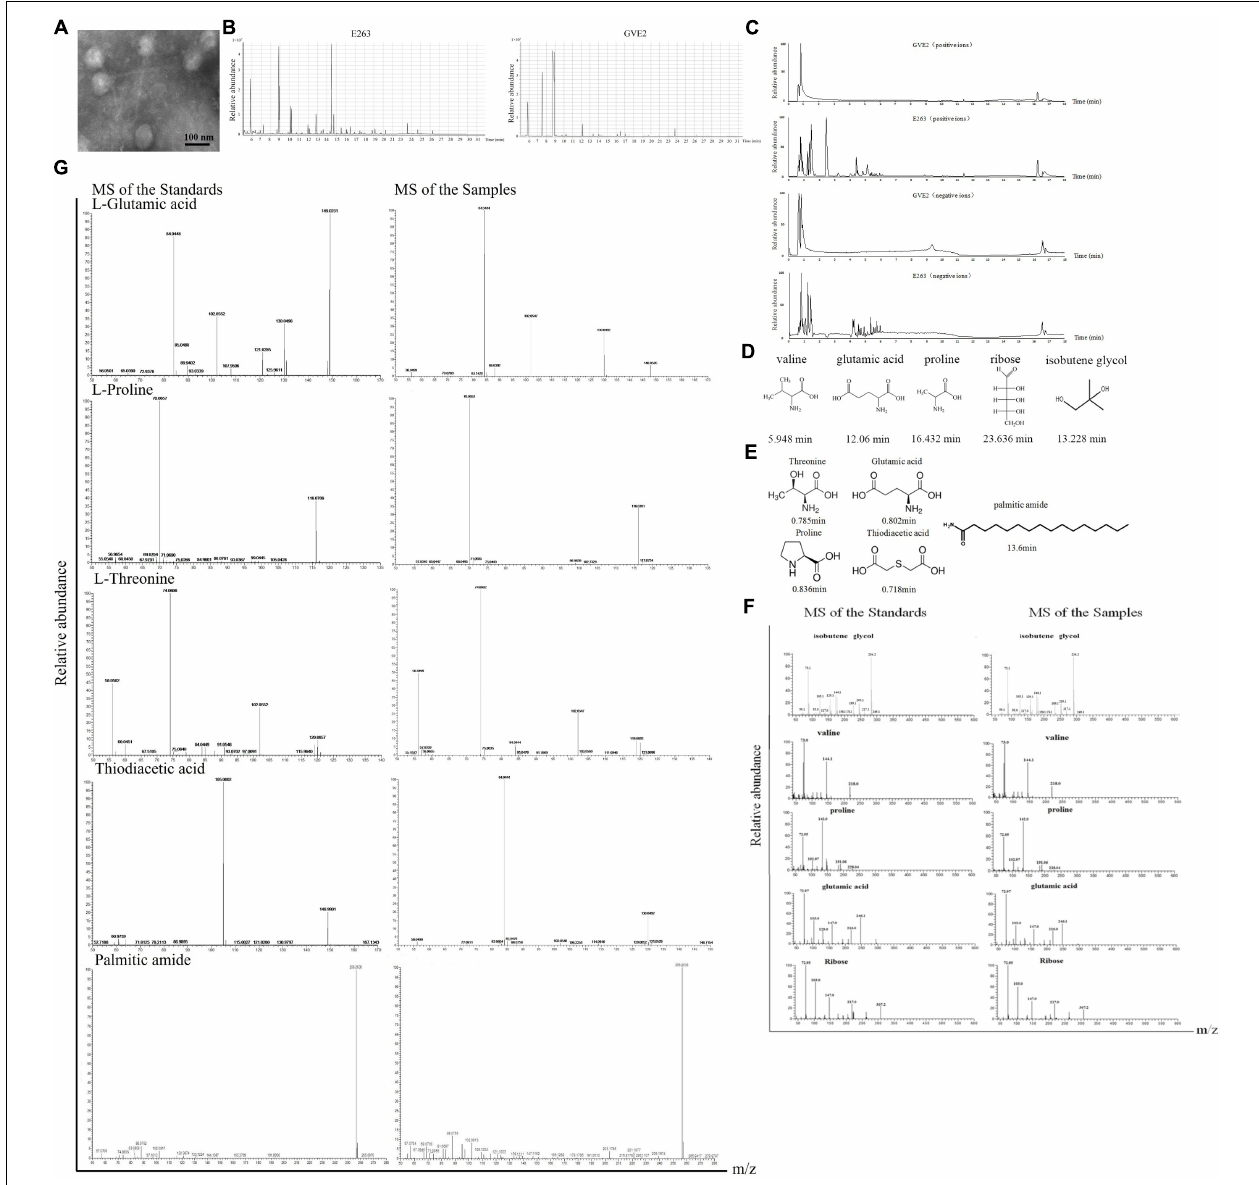
FIGURE 1 | Identification of metabolites packaged in virus particles. (A) Purification of virions. The purity of purified GVE2 virions was examined with transmission electron microscopy. Scale bar, 100 nm. (B) GC-MS analysis of the metabolites extracted from the purified virions and the virus-infected bacteria. Geobacillus sp. E263 was infected by its bacteriophage GVE2. At 1 h post-infection, the bacteria were subjected to compound extraction. The compounds extracted from the purified GVE2 virions and the GVE2-infected E263 were analyzed by GC-MS. Relative abundance of the compounds was plotted with retention time in minute. (C) LC-MS analysis of the metabolites packaged in GVE2 virions. The compounds extracted from the purified GVE2 virions and the virus-infected bacteria were identified by LC-MS. (D) The compounds of GVE2 virions identified by GC-MS. The retention time was indicated in minutes. (E) The compounds of GVE2 virions identified by LC-MS. (F) The GC-MS analysis of the standards and the samples (the compounds from the purified GVE2 virions). The retention time was indicated in minutes. (G) The LC-MS analysis of the standards and the samples (the compounds from the purified GVE2